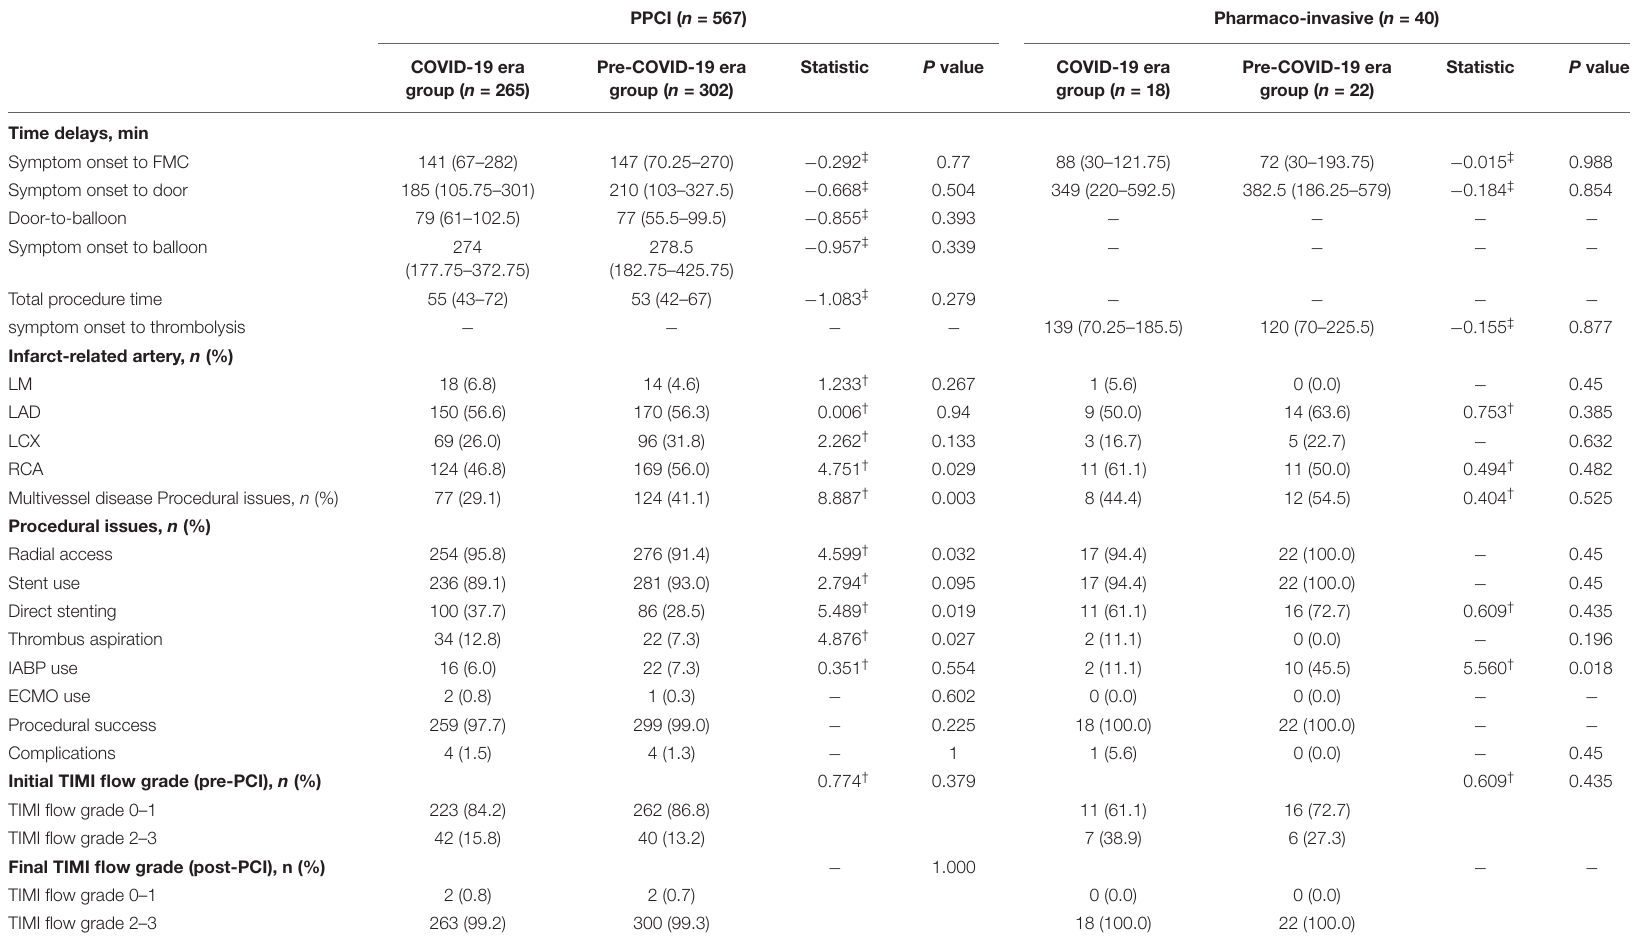
TABLE 2 | Angiographic characteristics and procedural